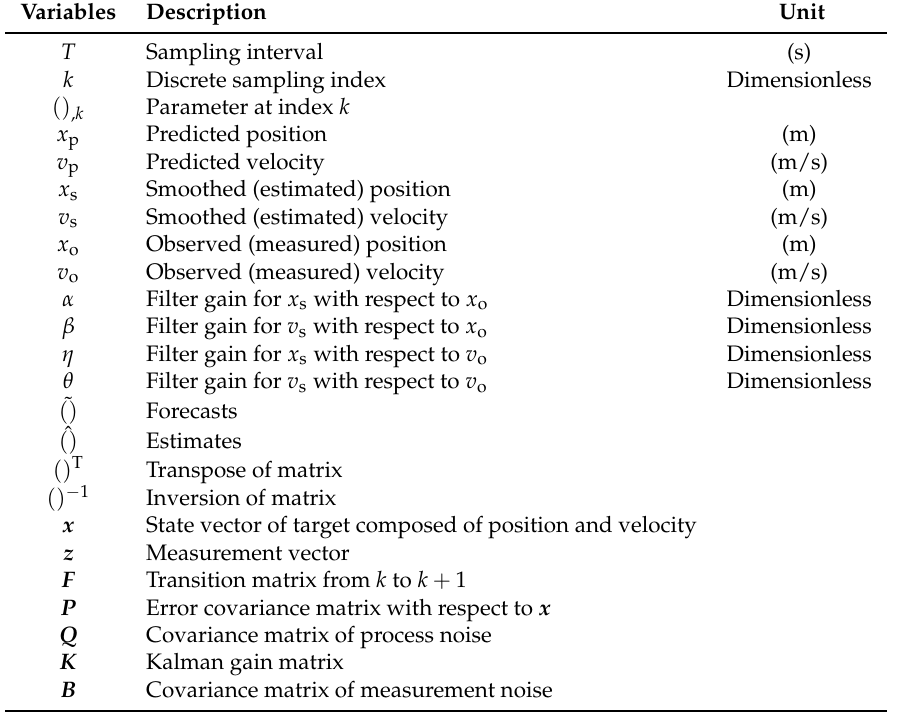
Table 1. List of